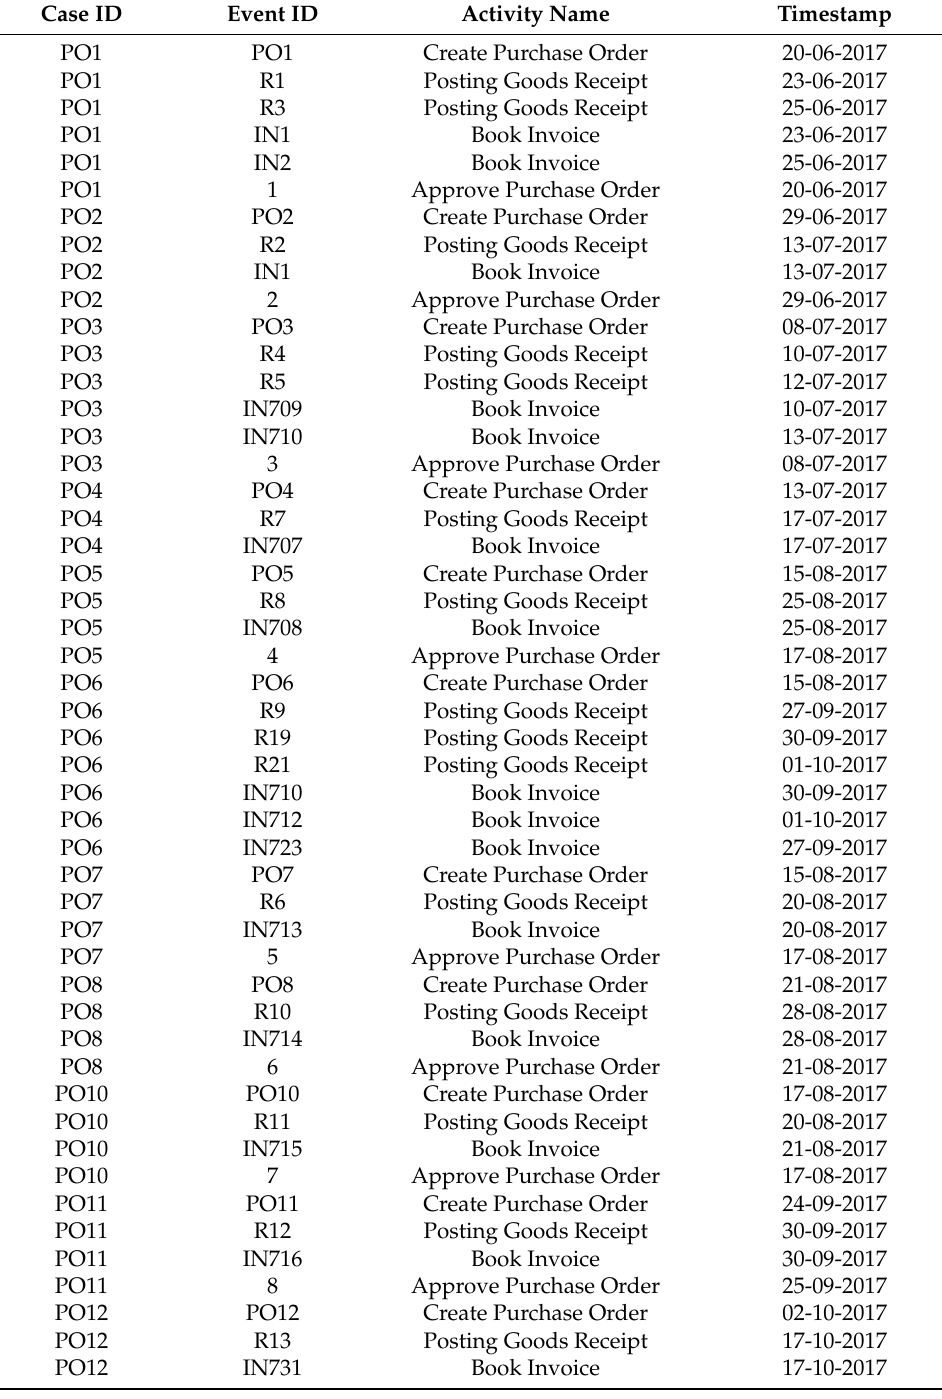
Table 4. A fragment of the event log extracted from the real data of a NAV ERP